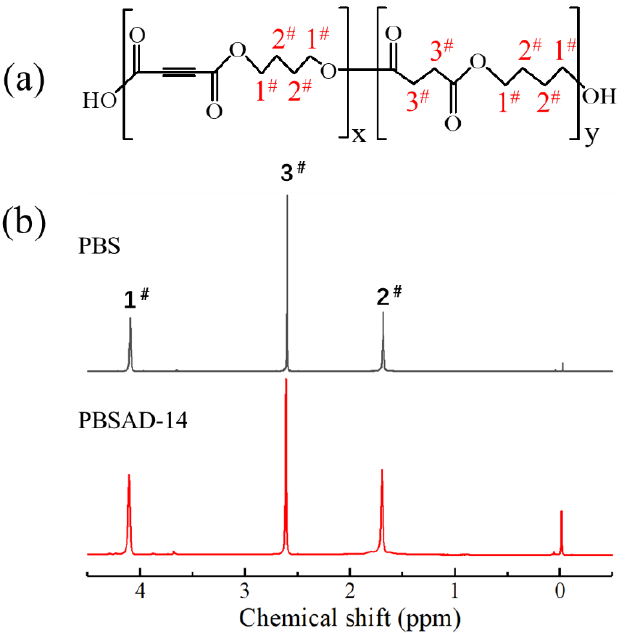
Figure 1. ( a ) Chemical structure of poly(butylene succinate- co -butylene acetylenedicarboxylate) (PBSAD) and ( b ) the 1 H NMR spectra of poly(butylene succinate) (PBS) and PBSAD-14.